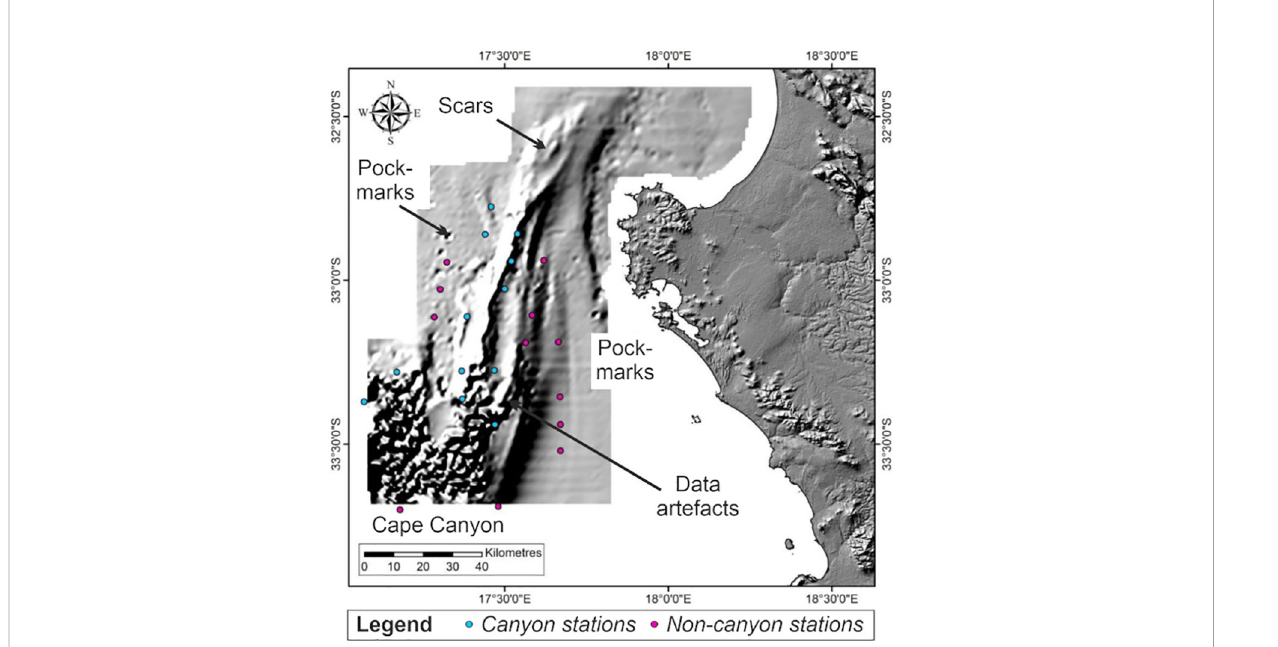
FIGURE 2 Map showing canyon vs. non-canyon stations overlaid onto bathymetry data (grey shading) collected through this